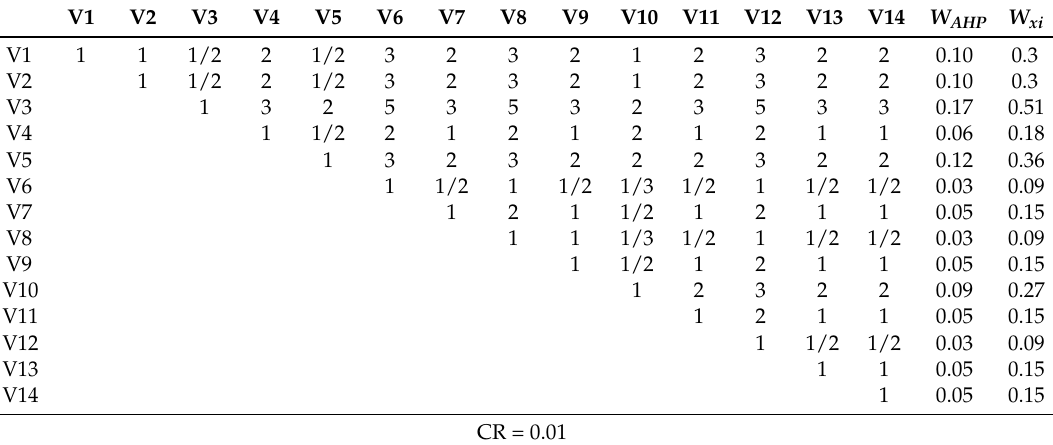
Table 5. The weights estimated from the analytical hierarchy process model and the final weight for the indicators of the vulnerability factor. For the definition of V1, V2 . . . V14, see Table 2.